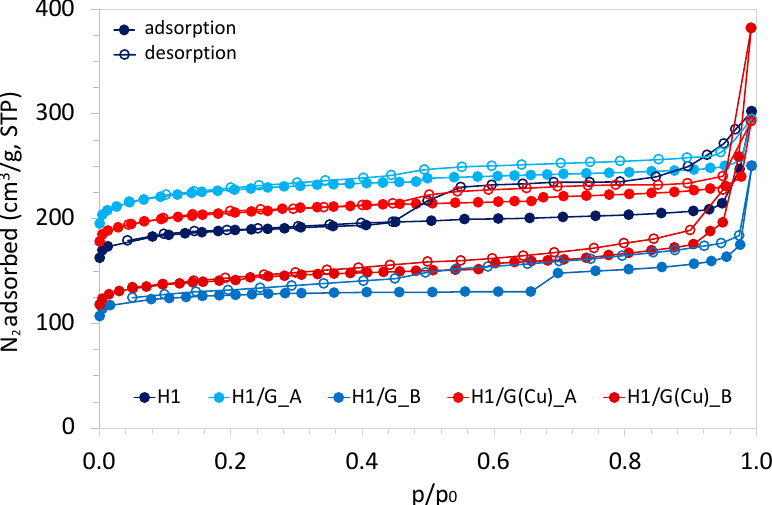
Figure 9. N 2 adsorption–desorption isotherms at standard temperature and pressure (STP) for HKUST-1 and HKUST-1/GO composites; filled symbols stand for the adsorption; open symbols stand for the desorption. Table 4. Textural properties of HKUST-1, GO, Cu/rGO, and HKUST-1/GO composites. S BET —spe-